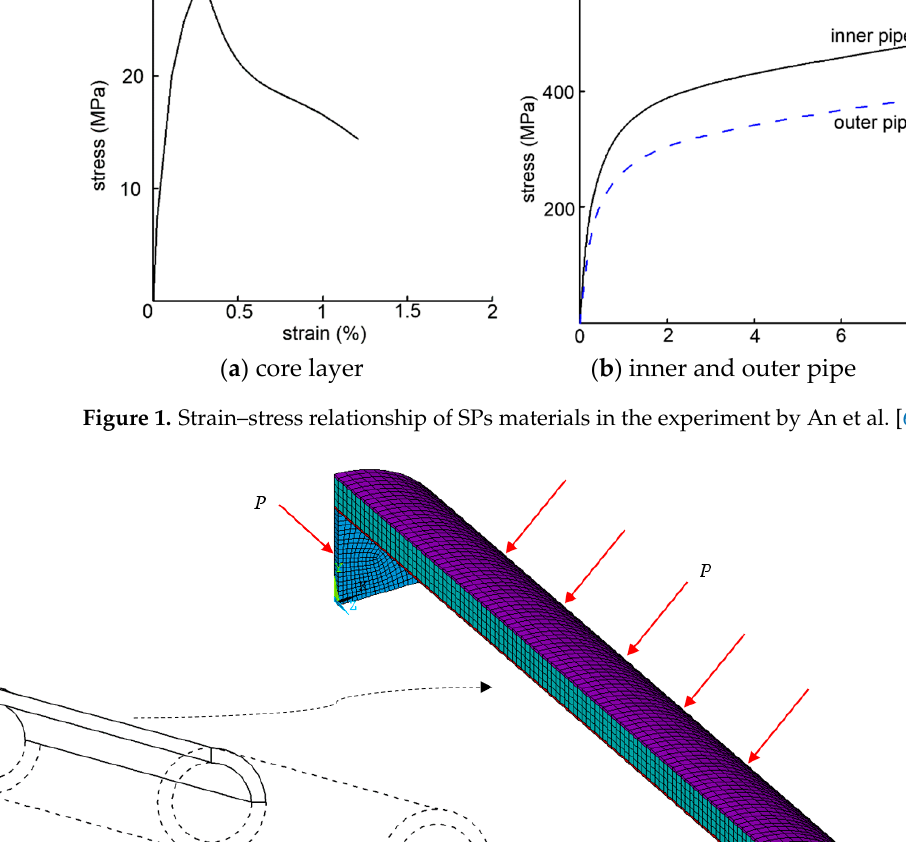
Figure 1. Strain–stress relationship of SPs materials in the experiment by An et al. [6].